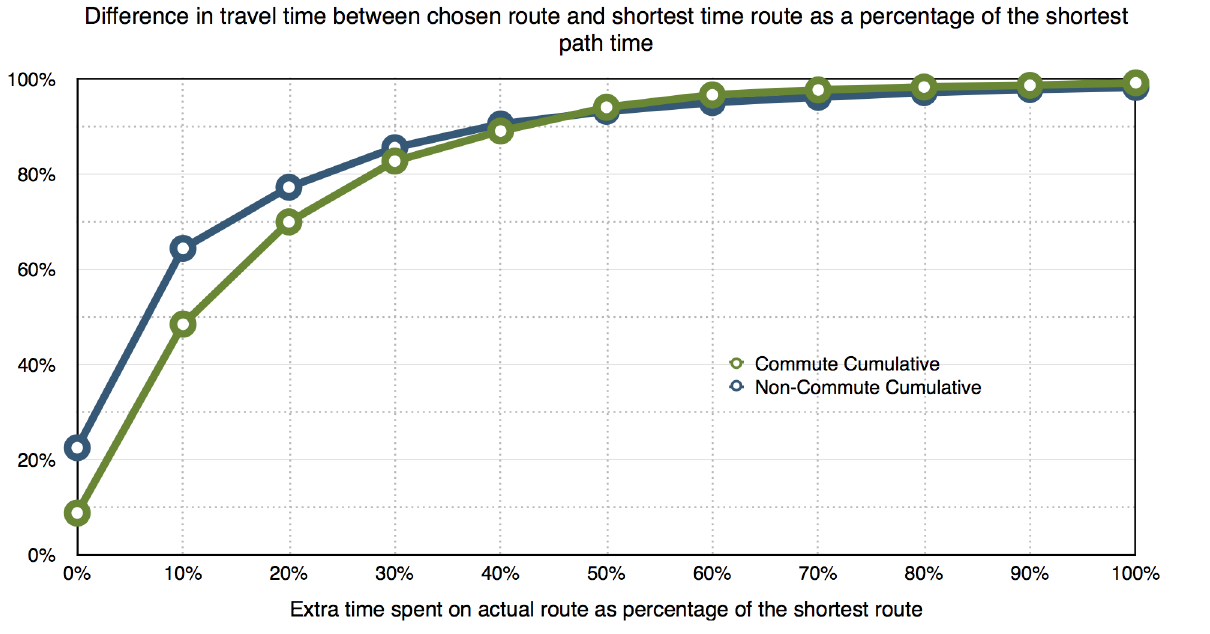
PLOS ONE | DOI:10.1371/journal.pone.0134322 August 12,